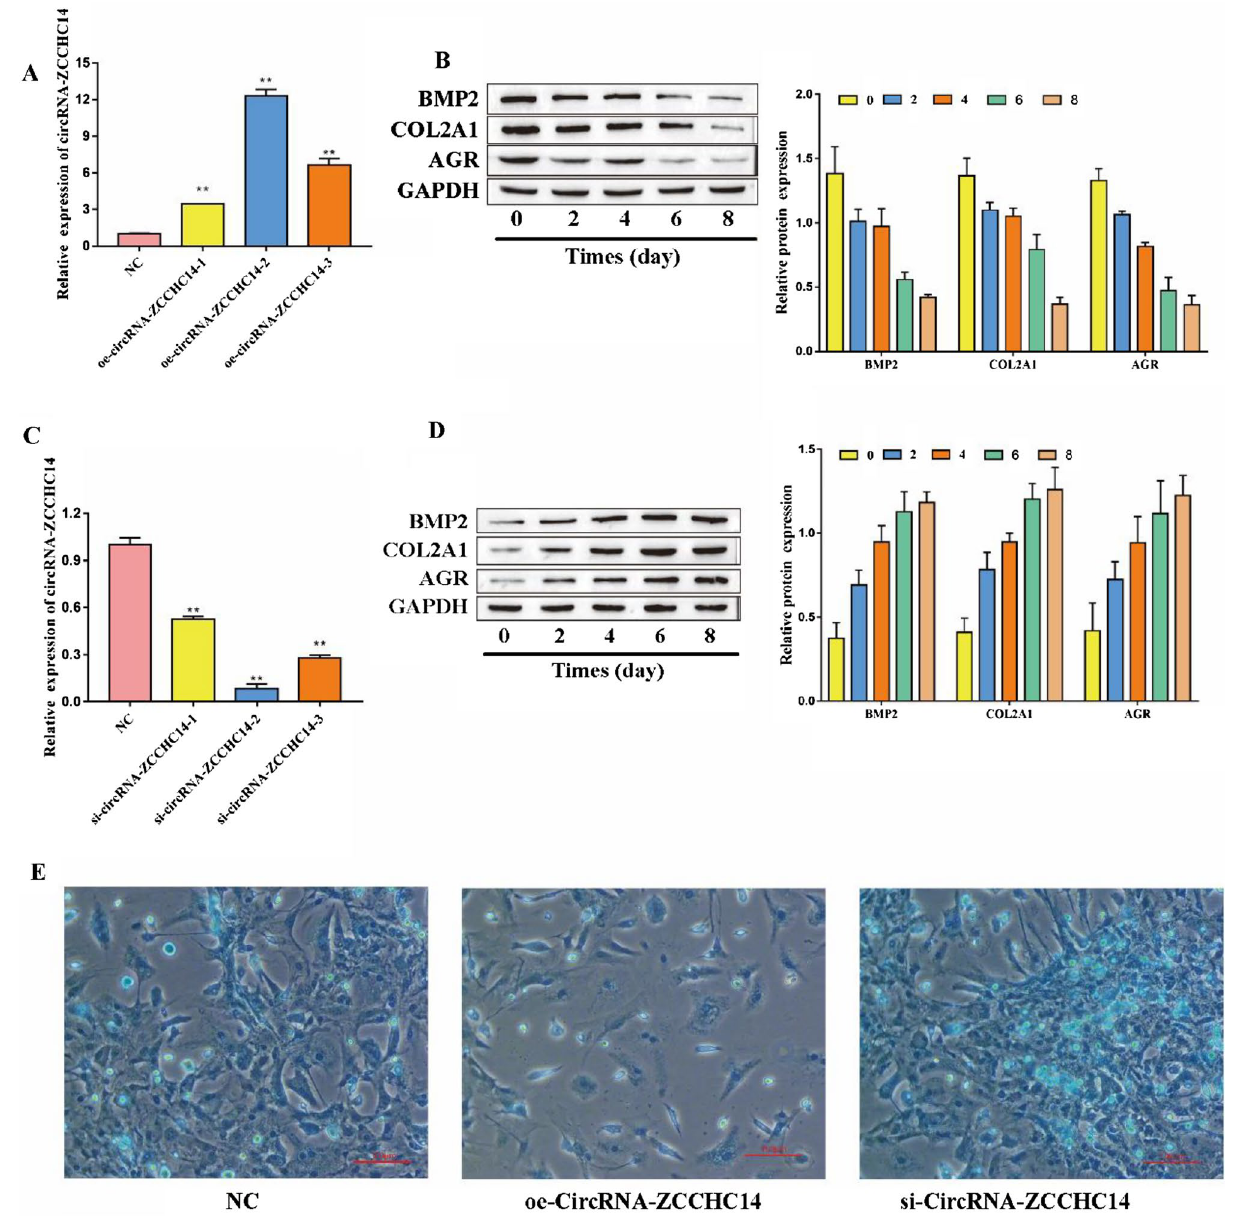
Figure 2. The effect of circRNA-ZCCHC14 on the chondrogenic differentiation of PBMSCs ( A ) RT ‒ qPCR detection of circRNA-ZCCHC14 overexpression efficiency; ( B ) Western blot detection of the expression of the cartilage markers BMP2, COL2A1 and AGR; ( C ) RT ‒ qPCR detection of the circRNA-ZCCHC14 knockdown efficiency; ( D ) Western blotting was used to detect the expression of the cartilage-forming markers BMP-2, COL-2A1 and AGR; ( E ) Alcian blue staining was used to detect the ability of cells to form